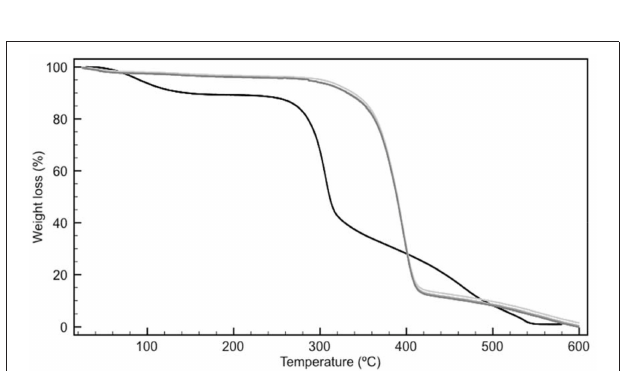
FIGURE 2 | Thermogravimetric analysis of unmodified galactomannan (G —) and galactomannan acetate treated with 10mL (GA1 —), 20mL (GA2 —) and 30mL (GA3 —) of acetic anhydride. Two replicates were performed for each sample.